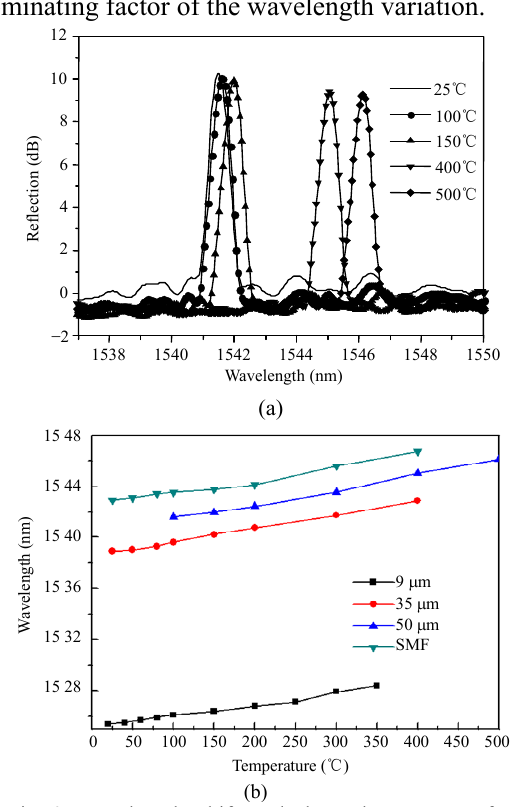
(b) Fig. 3 Wavelength shift and thermal response of FBG: (a) wavelength shift of FBG (50  m) during heating up and (b) thermal response of FBG with fiber diameters of 9  m, 35  m, 50  m, and an SMF.